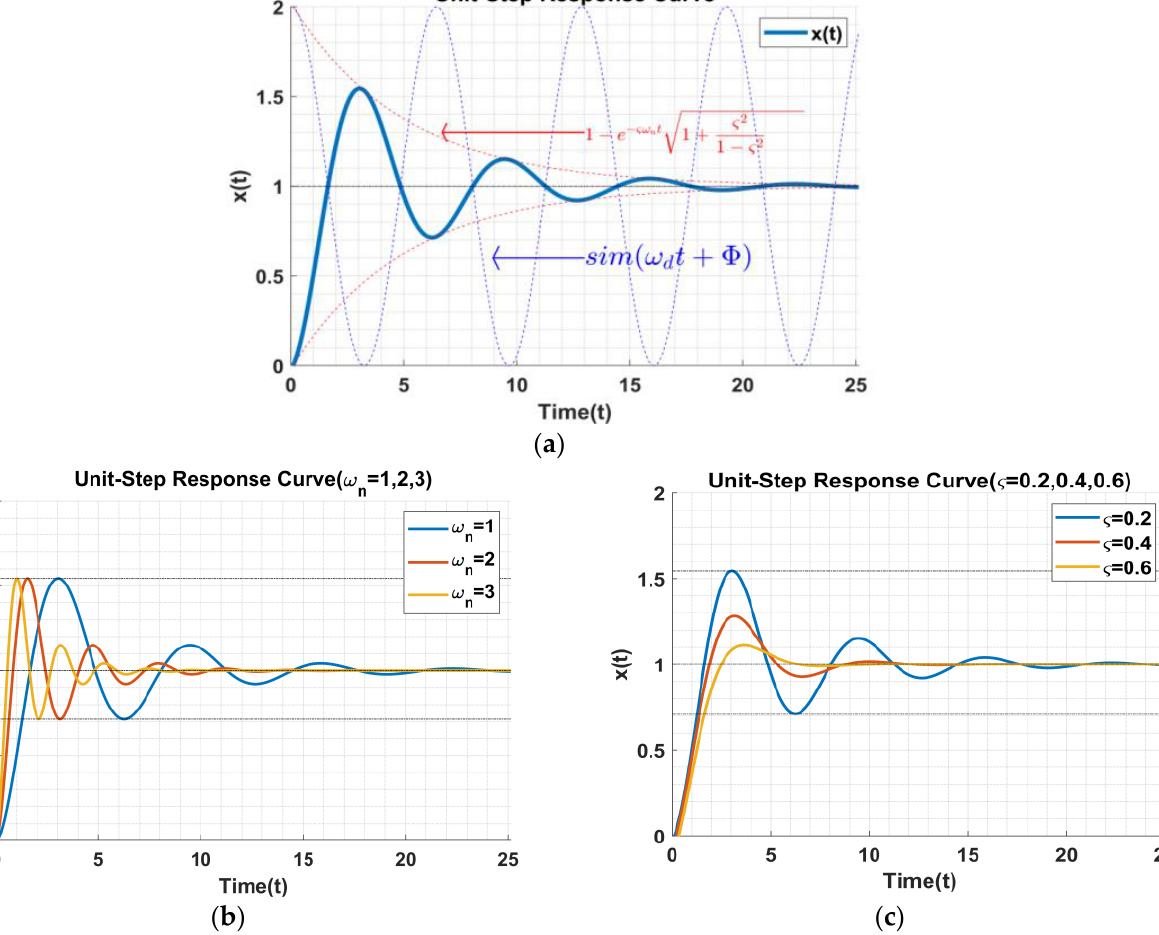
Figure 9. Step response curve of second-order, underdamped system. ( a ) System Compound Curve; ( b ) Natural Frequency Dynamic Effects; ( c ) Dynamic Influence of Damping Ratio.